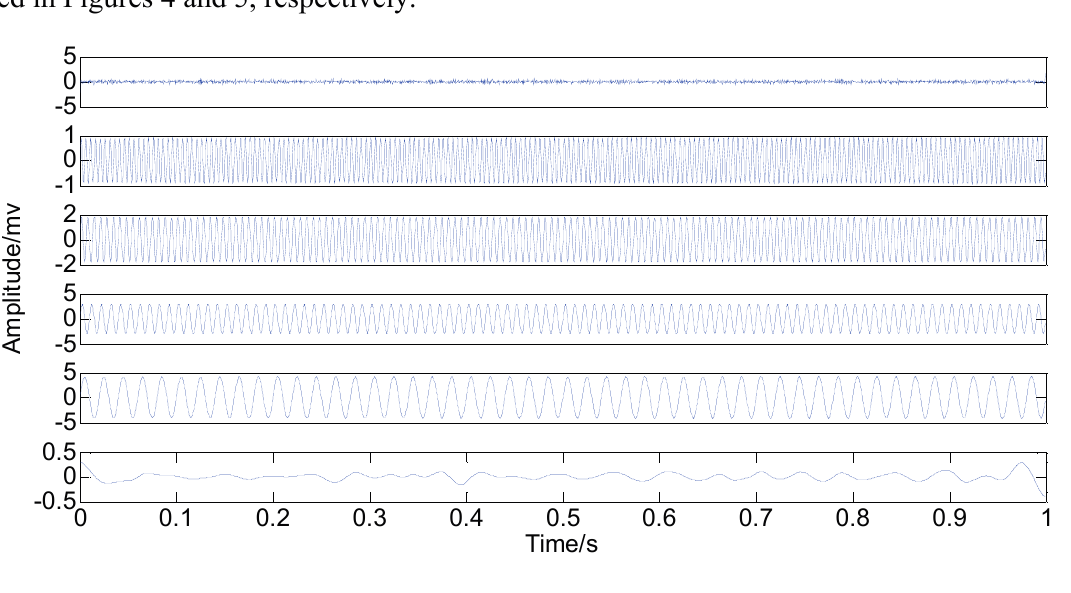
Figure 4. Modified Intrinsic Mode Functions (IMFs) in the